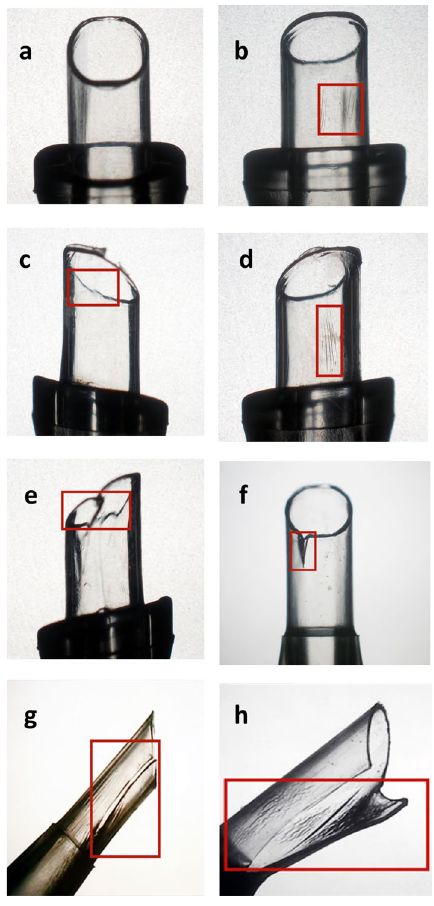
Figure 4. Representative microscopic images of each damage scale (under ×4 magnification). ( a ) No damage. ( b ) Red square indicates fine stress lines on the inner tube, graded as “slight scratches”. ( c ) Red square indicates slight discontinuity at the nozzle tip, graded as “slight scratches”. ( d ) Red square indicates deep stress lines on the inner tube, graded as “deep scratches”. ( e ) Red square indicates obvious discontinuity at the nozzle tip, graded as “deep scratches”. ( f ) Red square indicates partial crack of inner tube, graded as “extension”. ( g ) Red square indicates full thickness of inner tube crack, graded as “crack”. ( h ) Red square indicates burst of the nozzle tube, graded as